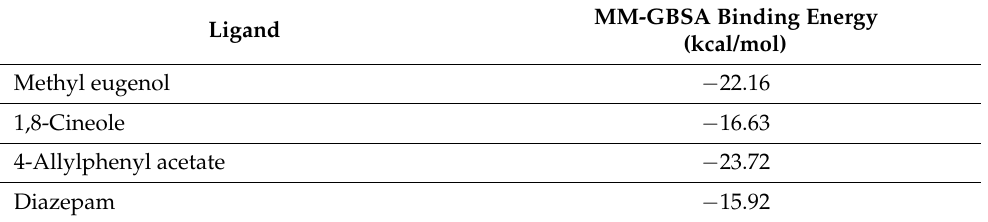
Table 2. Interaction of GABA A receptor and the ligands. MM-GBSA energies of all models are